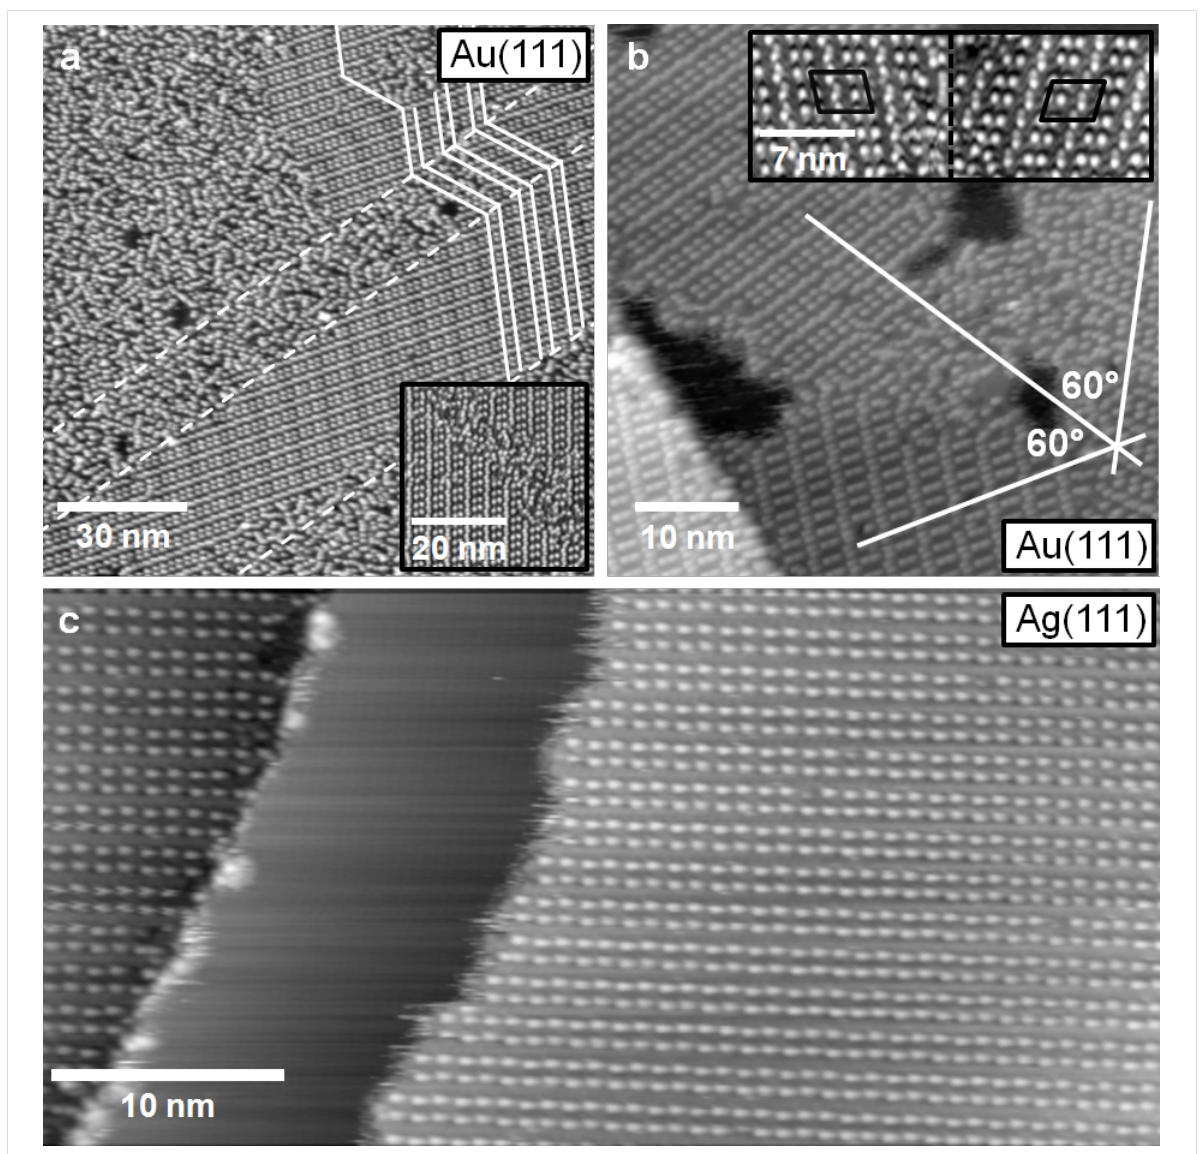
Figure 5: (a) STM image of a monolayer film of [BMP][TFSA] on Au(111), showing both 2D crystalline islands as well as 2D glass areas. The Au(111) reconstruction is visible in the 2D crystalline island (for better visibility it is marked with white lines in the upper right of the image). In the 2D glass domain, this is not resolved; dashed lines mark the domain boundaries of the Au(111) reconstruction pattern ( T = 118 K, U T = − 1.25 V, I T = − 0.060 nA). (b) STM image of 2D crystalline domains of [BMP][TFSA] on a single Au(111) terrace in direct contact to each other. The domains are rotated by 60° to each other ( T = 146 K, U T = − 1.20 V, I T = 60 pA). (c) STM image of a submonolayer film of [BMP][TFSA] on Ag(111). The adlayer islands nearly completely consist of the 2D crystalline structure. The island boundary shows a frizzy appearance, which is associated with mobility of the adsorbed IL species, either along the island edge or in a 2D adsorption–desorption equilibrium between the 2D solid and the adjacent 2D gas phase ( T = 130 K, U T = − 1.09 V, I T = 80